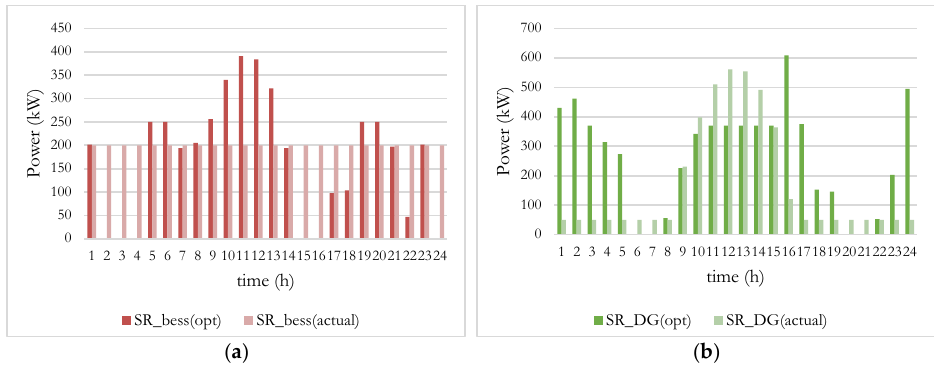
Figure 6. Comparison between spinning reserve of case study and MIP model. ( a ) BESS spinning reserve; ( b ) DG spinning reserve. Table 10. Comparison between case study and MIP model’s results.